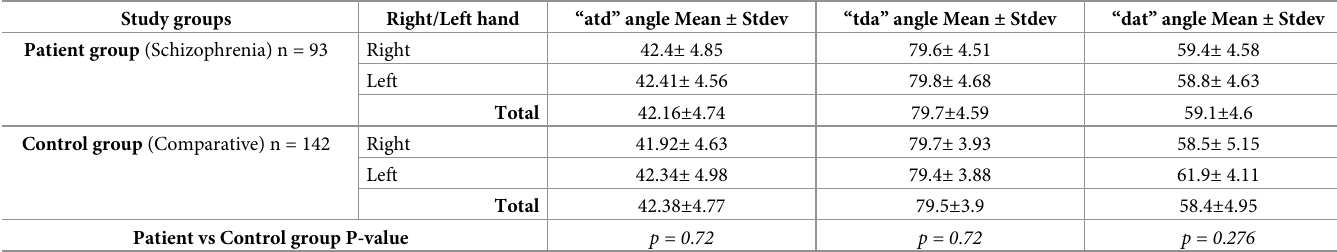
Table 9. Mean values of angles of atd, tda and dat in study groups.